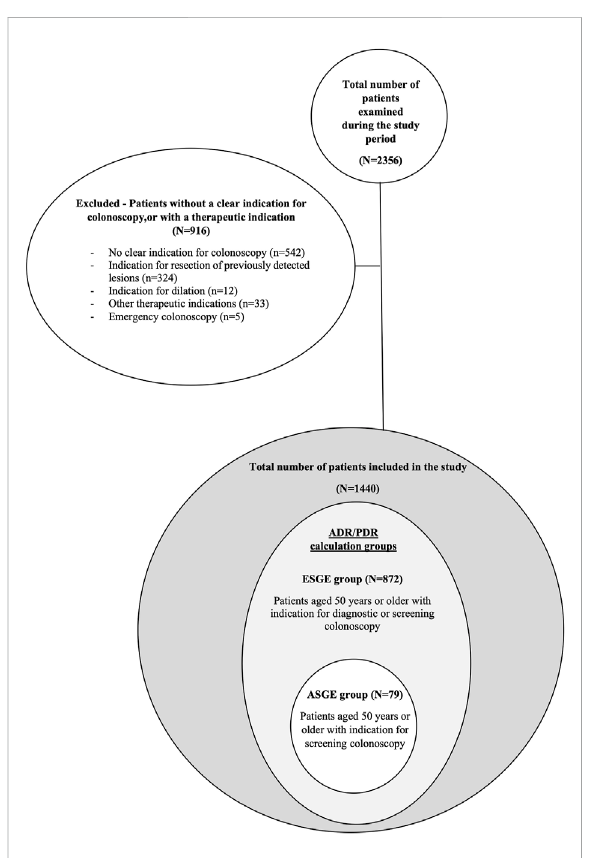
FIGURE 1 Flow chart of exclusion criteria and ADR/PDR calculations groups.